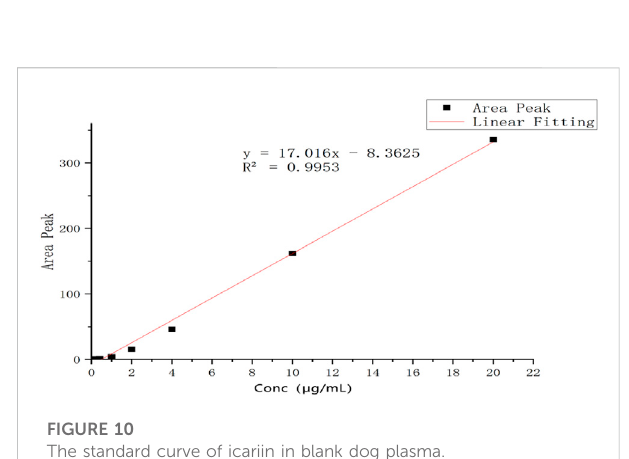
FIGURE 10 The standard curve of icariin in blank dog